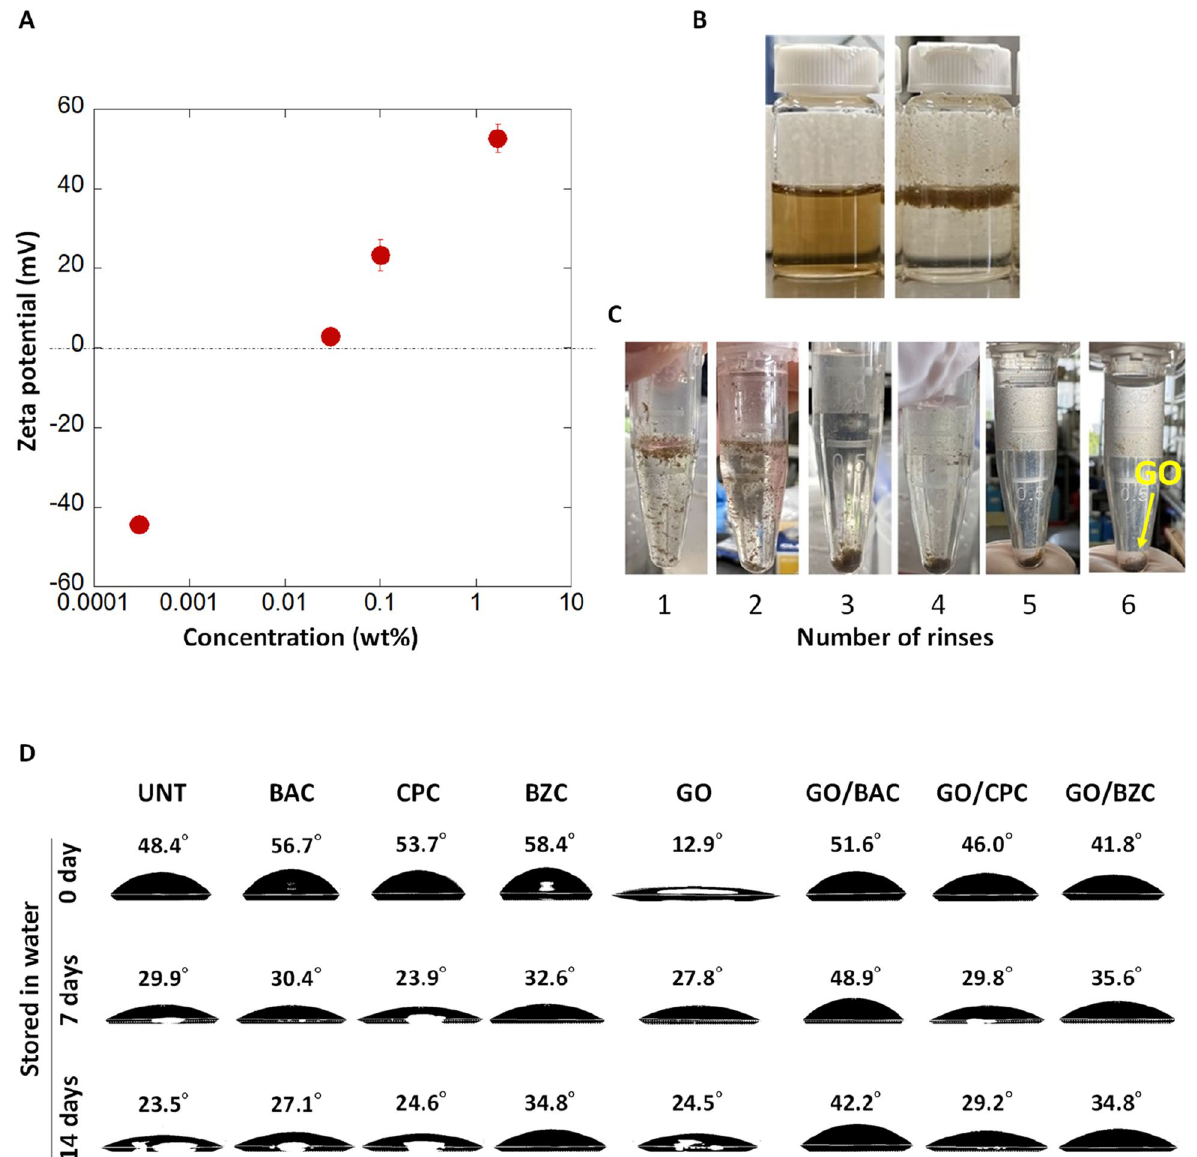
Figure 3. ζ-Potential of GO/BAC 12 and hydrophilicity of GO/CSAA on quartz substrate. ( A ) ζ-Potential of GO dispersion at various BAC 12 concentrations. ( B ) Photographs of GO dispersions with different concentrations of BAC 12 , left to right: 0.0003 and 0.03 wt%. ( C ) Photographs of GO dispersion after repeating water rinsing. ( D ) Contact angle measurements. The number above each droplet is the contact angle for the sample. BAC benzalkonium chloride, BAC 12 benzyldodecyldimethylammonium chloride, BZC benzethonium chloride, CPC cetylpyridinium chloride, CSAA cationic surface active agent, GO graphene oxide, UNT